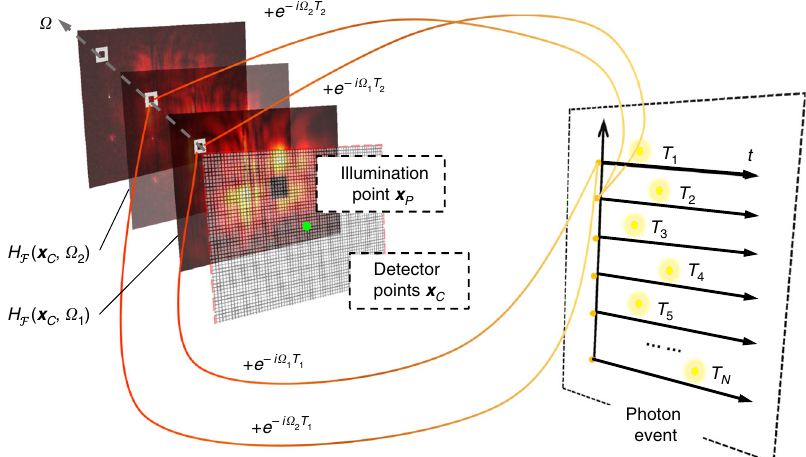
Fig. 6 Illustration of Fourier Domain Histogram. Instead of binning the photon event in time, we propose doing the binning in the frequency domain. This ; Ω Þ used for reconstructions. Ω stands for the frequency range for the phasor fi eld wavefront. allows us directly to sample the phasor fi eld wavefront H F ð x c The equation for the Fourier Domain Histogram can be applied during measurements, which is a summation of complex phasors (or a separated real and imaginary